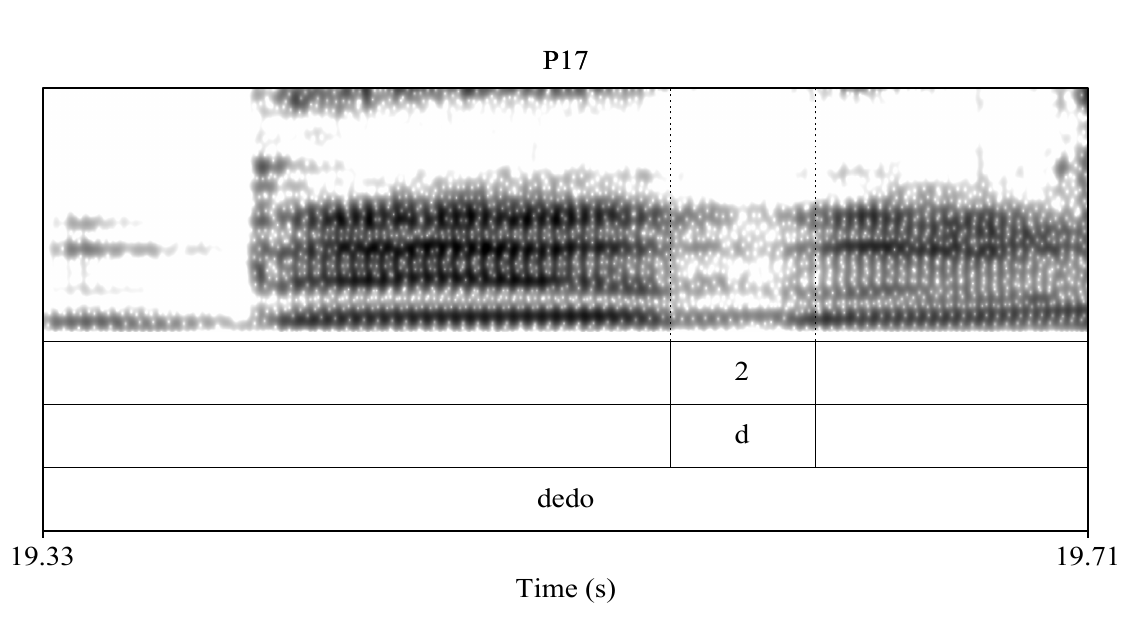
Figure 3. /d/ segment with a score of 2 (tense approximant).